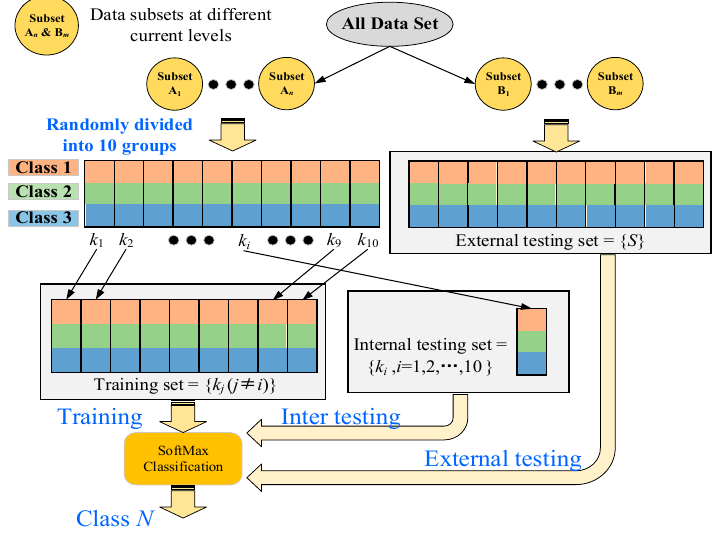
Figure 7. Overall procedures for GIS system diagnosis under different currents condition. Table 3. Training and testing data set.